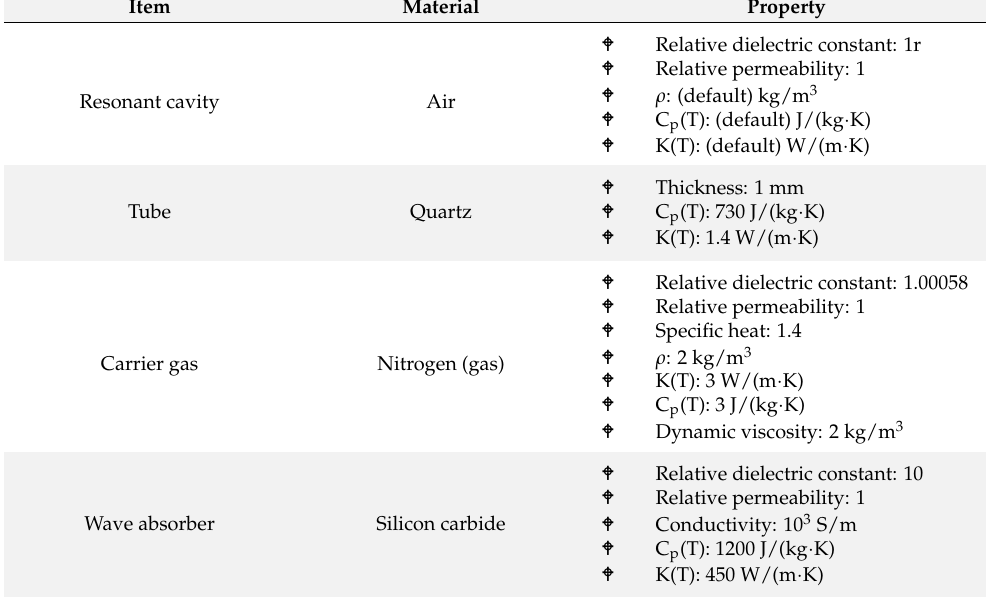
Table 1. Properties of the model materials.